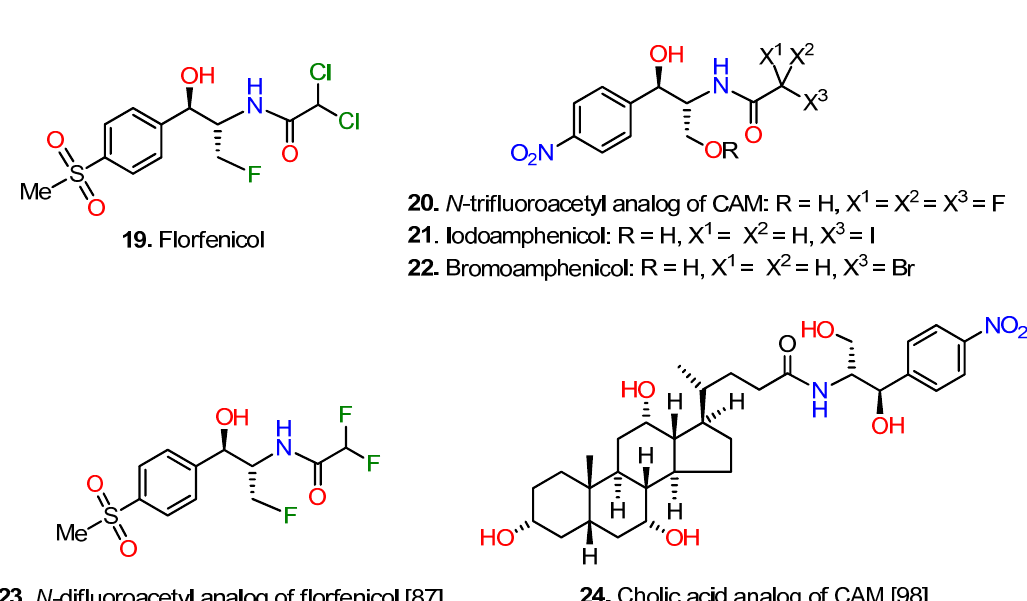
Figure 7. Florfenicol and derivatives of CAM modified at the dichloroacetyl moiety.